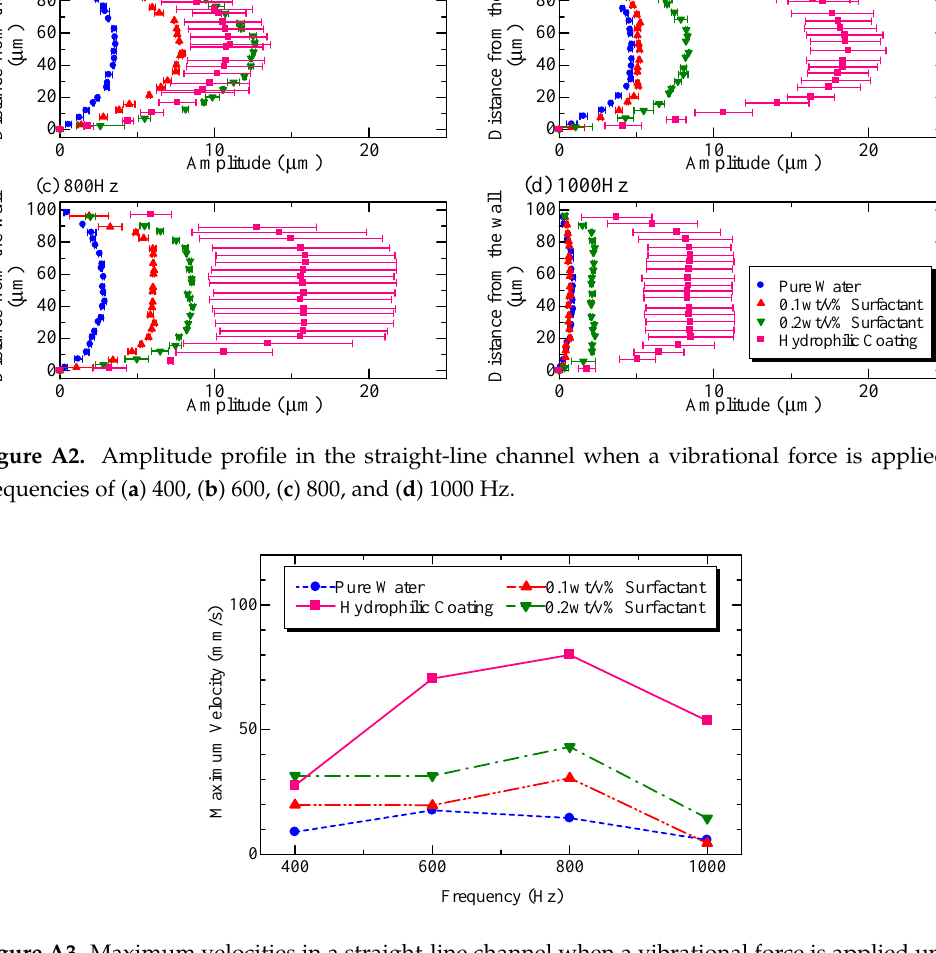
Figure A3. Maximum velocities in a straight-line channel when a vibrational force is applied under various